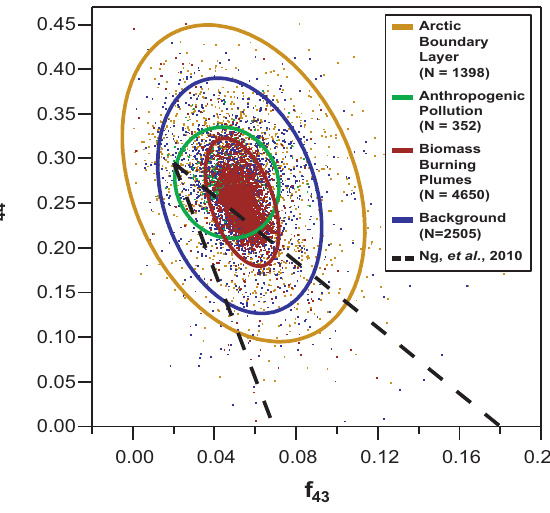
Fig. 8. Oxidation state of the aerosol expressed as f 44 versus f 43 , following (Ng et al., 2010). Points denote the 10-second-averaged observations for each air mass type, and the ellipses denote the 95% confidence regions. Dashed lines are the parameterized triangular bounding region reported by (Ng et al., 2010) for SOA chamber oxidation and ambient measurements.